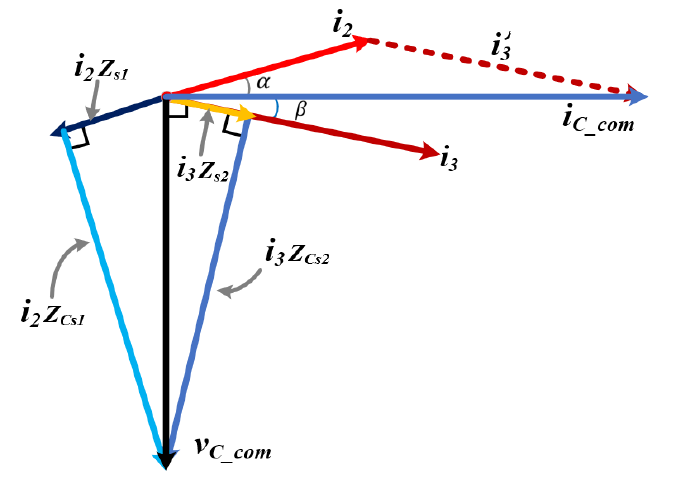
Figure 27. The phasor diagrams of equivalent circuit models with common capacitor connection.